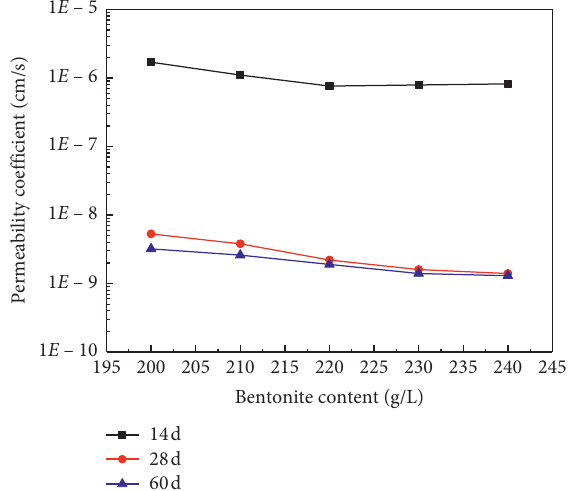
Figure 5: Curve of influence of different bentonite contents on permeability coefficient of